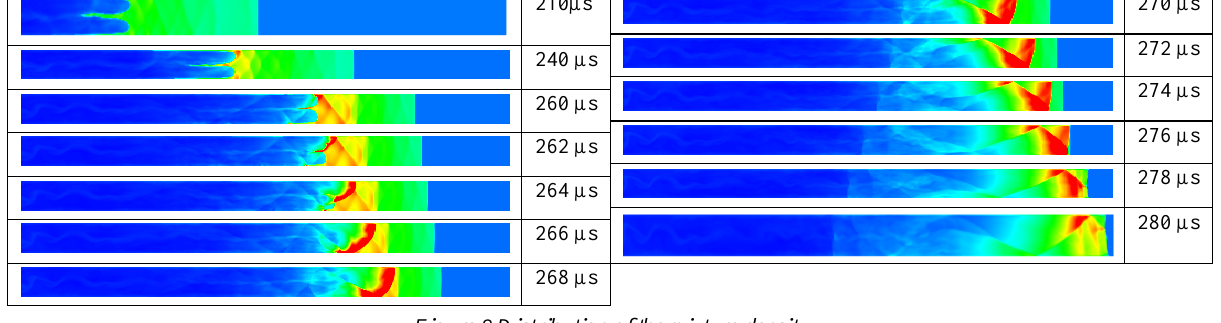
Figure 8 Distribution of the mixture density